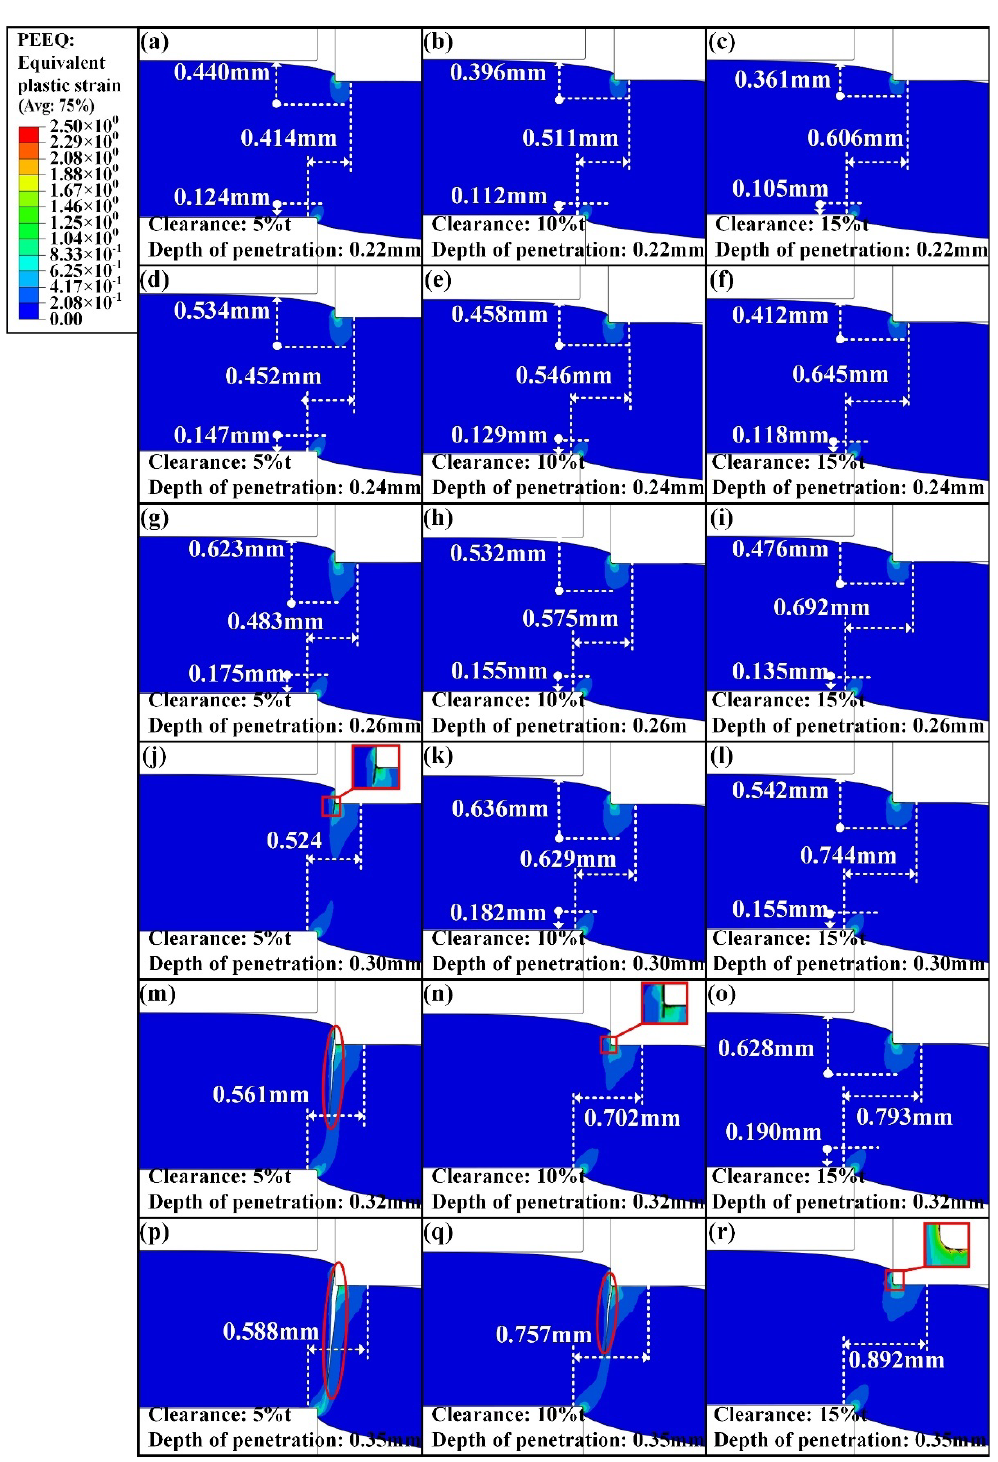
Figure 27. Strain distribution under the shearing clearances of 5%t, 10%t, and 15%t at different stages during the shearing process. ( a – c ) Depth of penetration = 0.13 mm. ( d – f ) Depth of penetration = 0.15 mm . ( g – i ) Depth of penetration = 0.17 mm. ( j – l ) Depth of penetration = 0.24 mm. ( m – o ) Depth of penetration = 0.26 mm. ( p – r ) Depth of penetration = 0.29 mm.